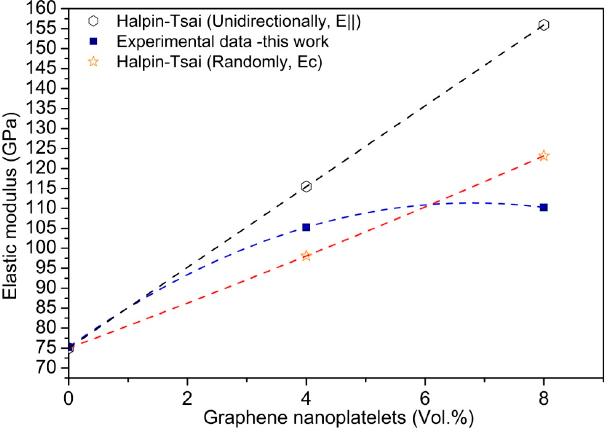
Figure 8. Comparison between the measured CTE and theoretical calculations of elastic modulus (Ec and E||) of Cu/GNPs composites as a function of GNP content.